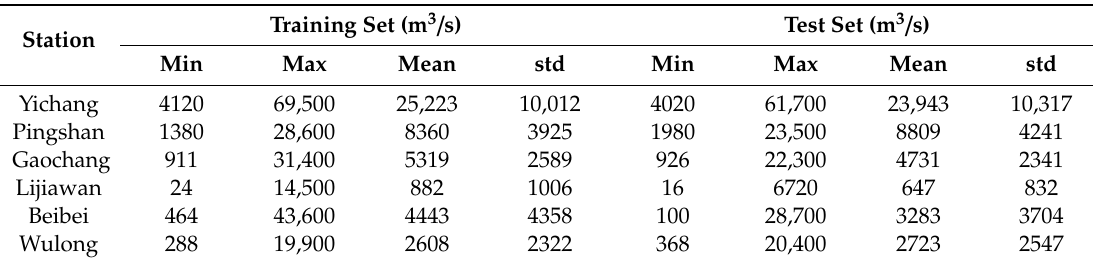
Table 1. Statistical information of training dataset and test dataset.